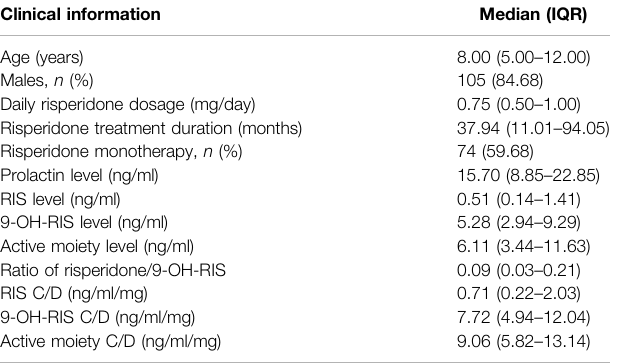
TABLE 1 | Patient demographics ( n (cid:1)